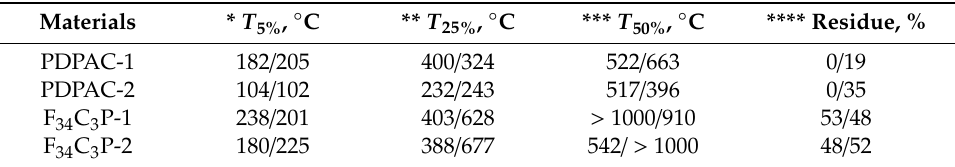
Table 4. Thermal properties of